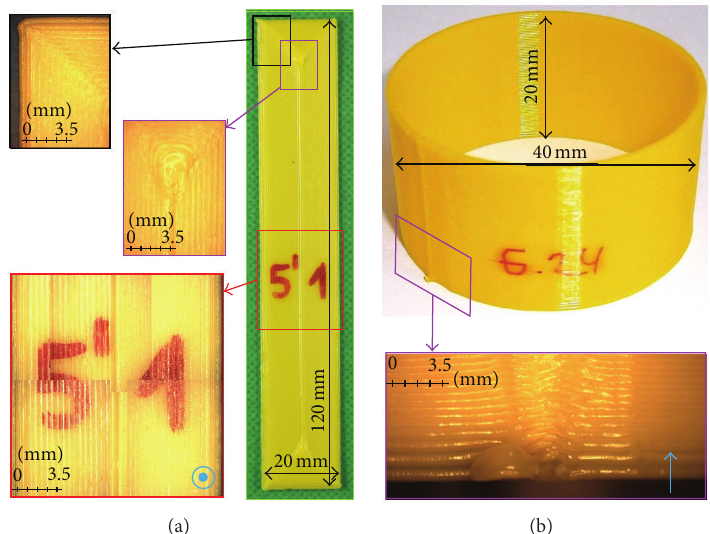
Figure 6: Typical macrostructure of selected specimens (blue = build direction). (a) Tensile specimen and (b) compression specimen.